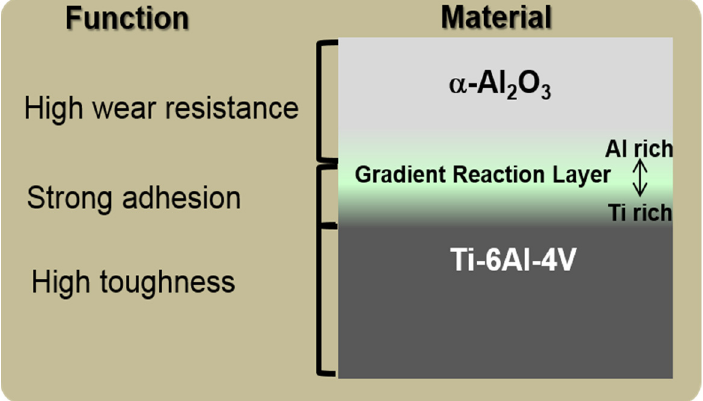
Figure 12. Schematic of cross-sectional view of a α -alumina layer on the Ti alloy with a gradient reaction layer at their interface. Reproduced from [103] with permission from Cambridge Core.